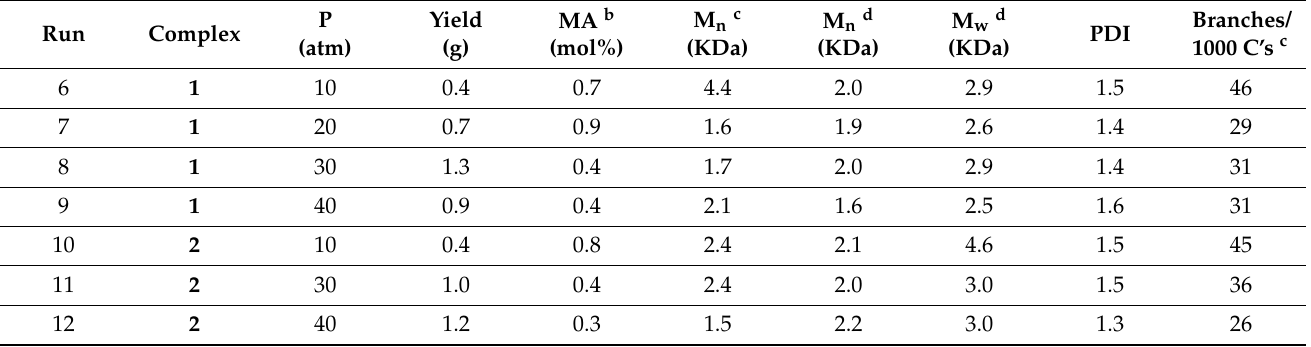
Figure 5. 1 H NMR (CDCl 3 , 300 MHz, T = 298 K) spectrum of the pentane-insoluble fraction of the Ethylene copolymer sample of run 3, Table 1.